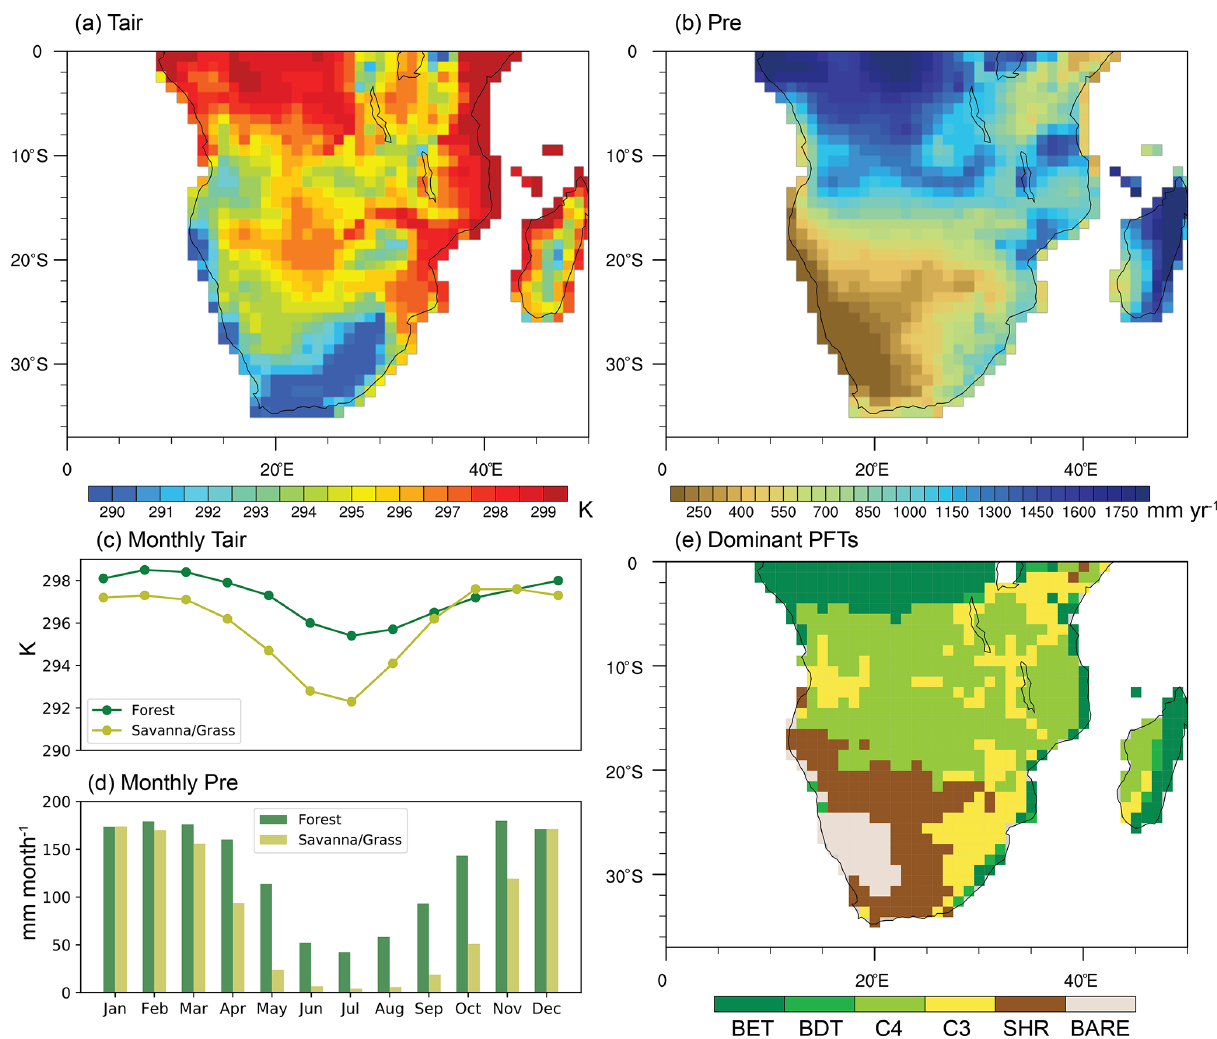
Figure 1. (a–d) Climate of SAF from Sheffield et al. (2006) averaged in 2000–2013: (a) annual mean air temperature ( T air ), (b) annual total precipitation (Pre), (c) monthly T air , (d) monthly Pre, and (e) dominant PFTs for each grid simulated in SSiB4/TRIFFID-Fire (BET: broadleaf evergreen tree; BDT: broadleaf deciduous tree; C4: C 4 grasses; C3: C 3 grasses; SHR: shrub; BARE: bare